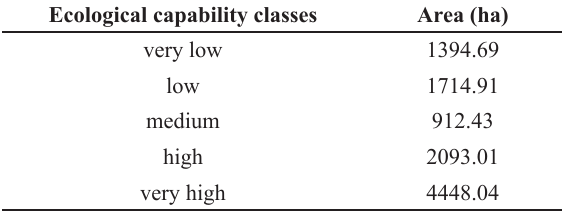
Area of overlay classes using AND operator.